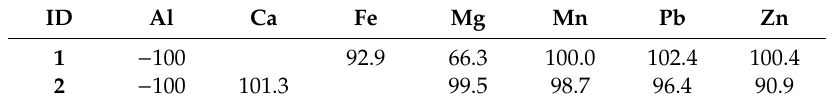
Table 8. Percentage reduction of PTEs from 50 / 50 stabilised moulds compared to raw BOF fine Sludge. ID Al Ca Fe Mg Mn Pb Zn 1 − 615.4 − 2498.7 95.5 96.9 94.2 2 − 916.8 101.6 99.2 100.0 99.7 Table 9. Percentage reduction of PTEs from 70 / 30 stabilised moulds compared to raw BOF fine Sludge. ID Al Ca Fe Mg Mn Pb Zn 1 − 100 92.9 66.3 100.0 102.4 100.4 2 − 100 101.3 99.5 98.7 96.4